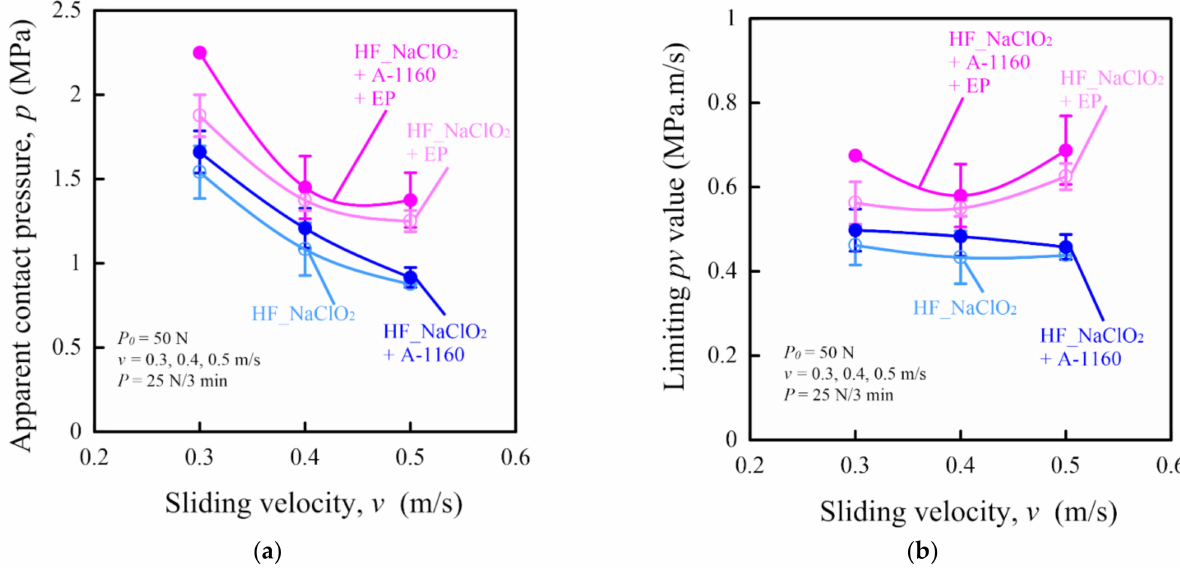
Figure 13. Tribological properties by the step load method of various surface-treated HF/PA1010 biomass composites: ( a ) apparent contact pressure as a function of sliding velocity and ( b ) limiting pv value as a function of sliding